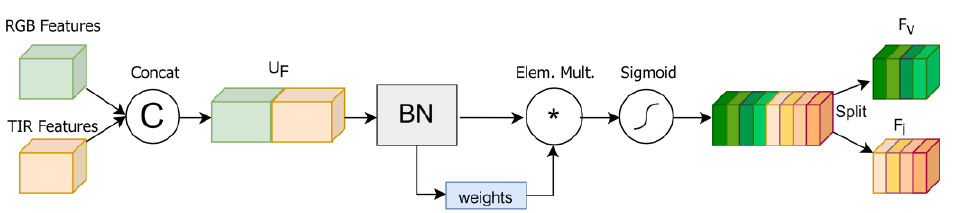
Figure 3. The architecture of MWPM. First, connect the depth features of RGB mode and thermal infrared mode and then assign weights to all channels.